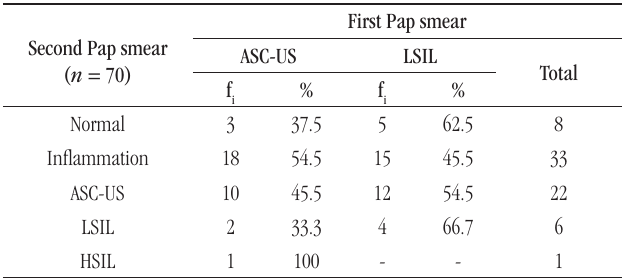
taBLE 2 – Comparative distribution of Pap results in the first and second